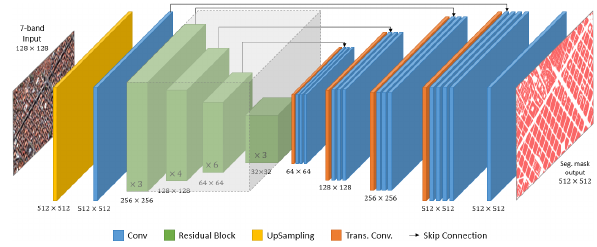
Figure 4. Network